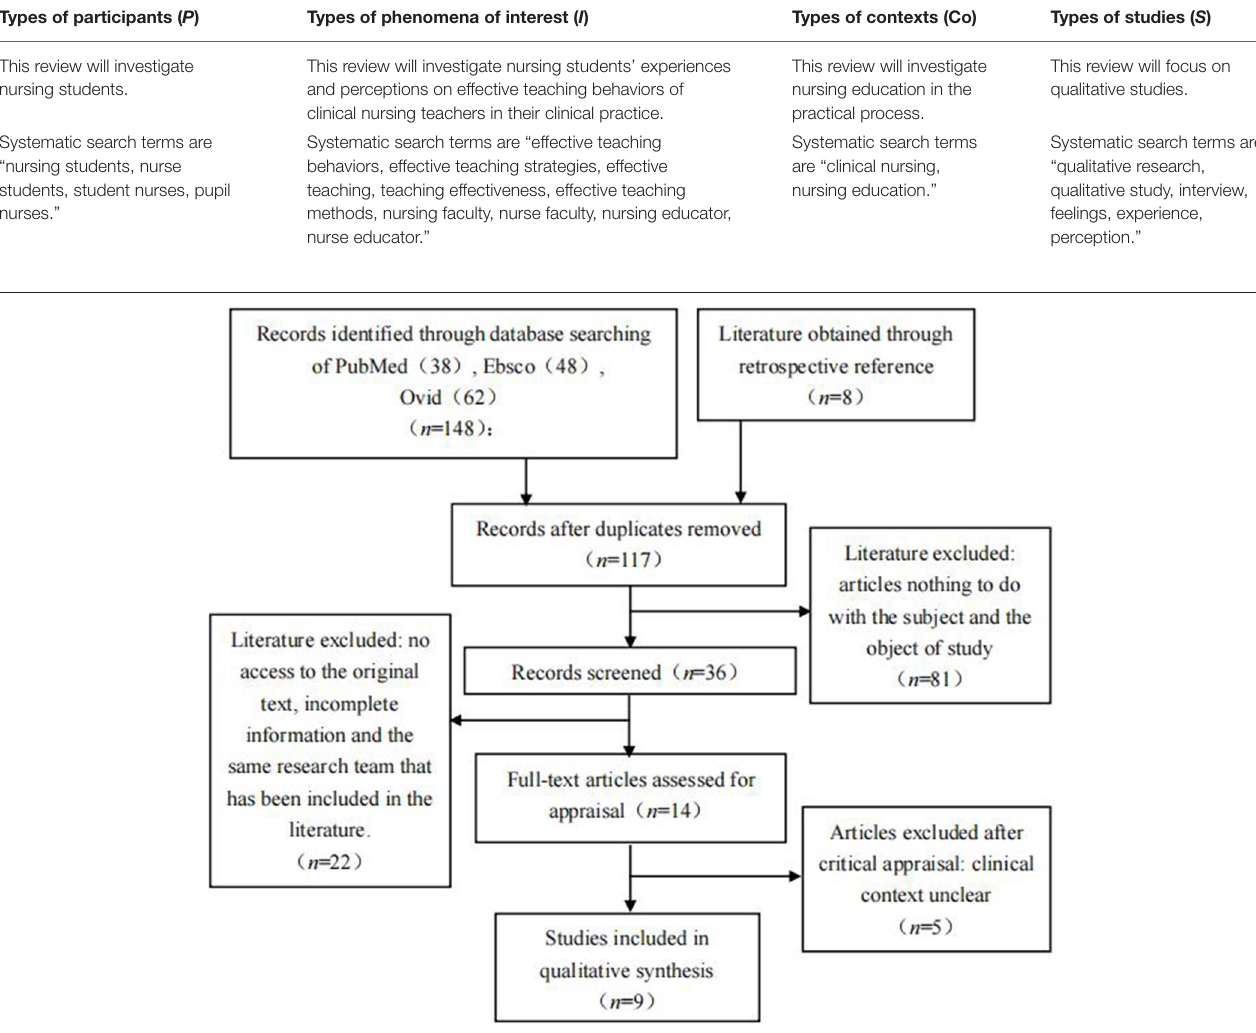
FIGURE 1 | PRISMA